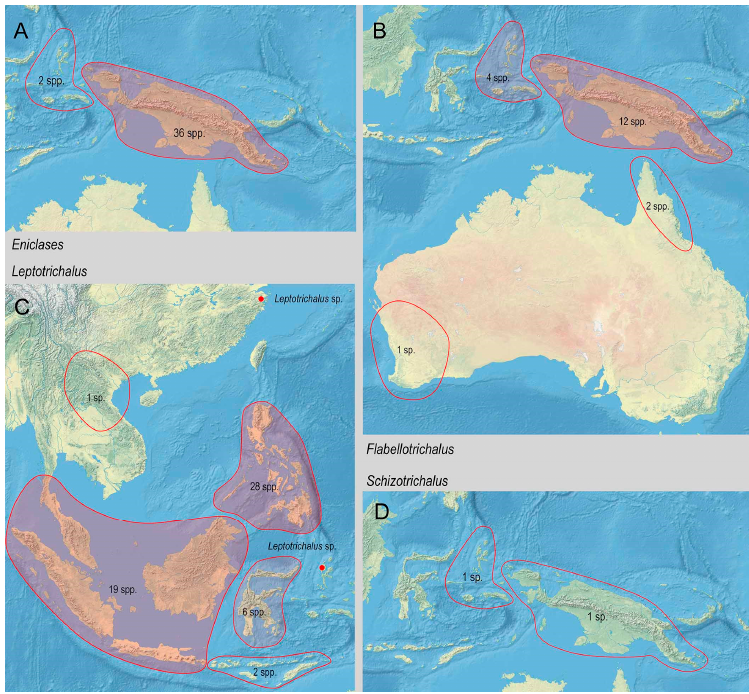
Figure 4. Distribution and diversity of Metriorrhynchina genera. ( A ) Eniclases Waterhouse, 1979; ( B ) Flabellotrichalus Pic, 1921; ( C ) Leptotrichalus Kleine, 1925; ( D ) Schizotrichalus Waterhouse, 1879.